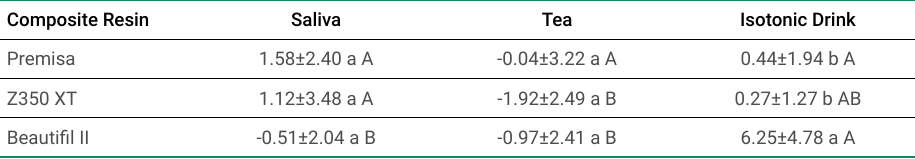
*Capital letter indicates statistical difference among columns. Lowercase indicates statistical difference among lines.